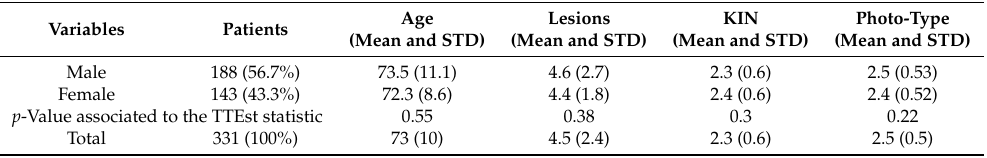
Table 1. Mean age, average number of lesions, keratinocyte intraepithelial neoplasia (KIN) and photo-type of all patients and for their